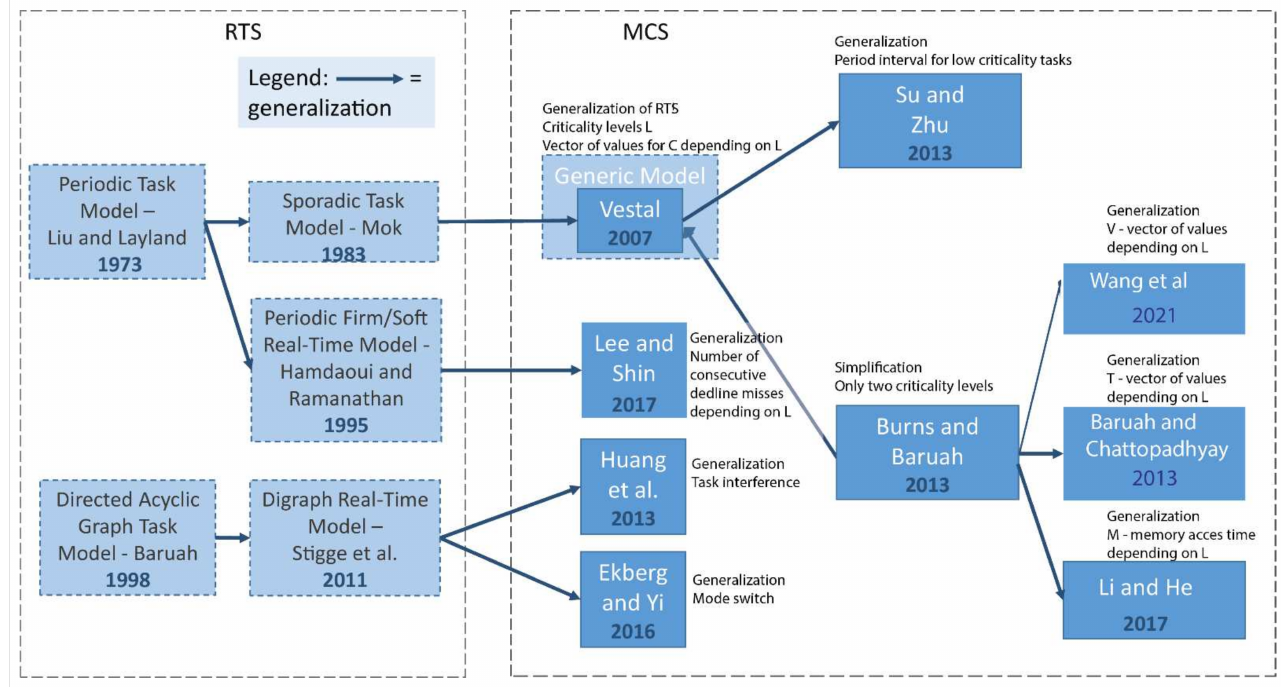
Figure 1. Task Models